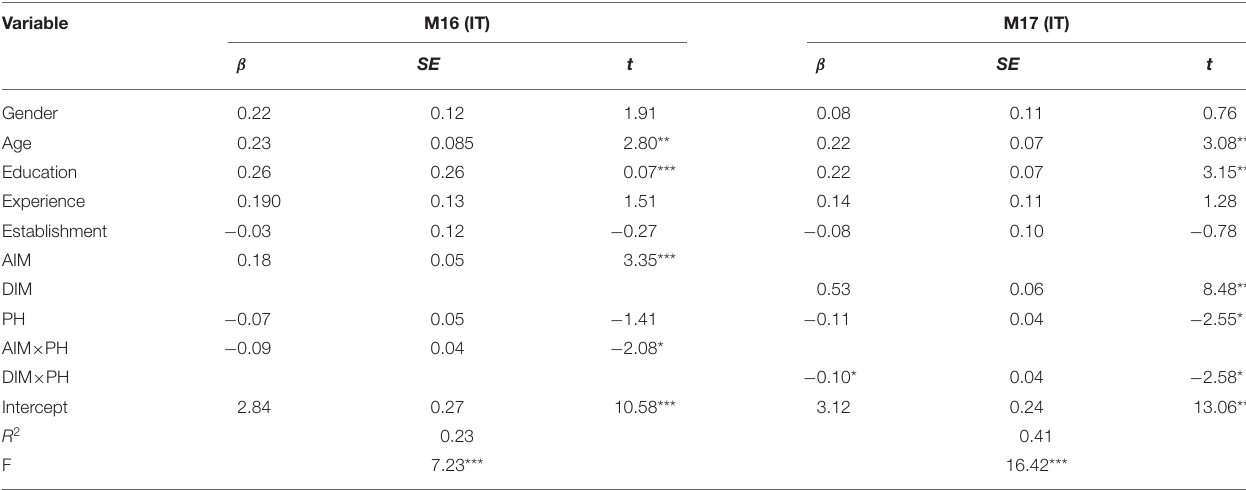
TABLE 5 | The moderating effect test of perceptions of hypocrisy.